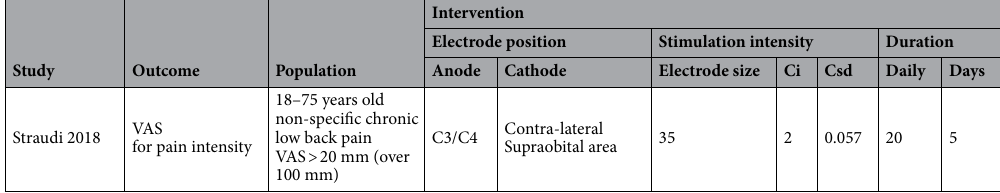
Table 14. Parameters. Pain. PICO variables for tDCS against pain, see the legend of Table 12